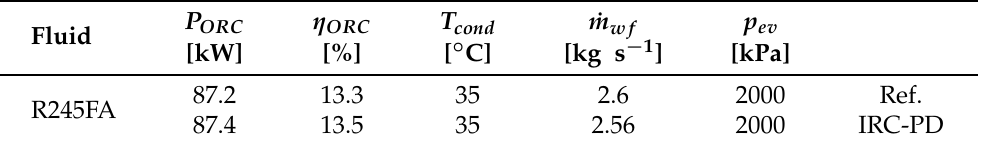
Table 4. Comparisons between the results obtained by the IRC-PD tool and the ones listed in ref. [60]. In the thermal loop flows the Dowtherm Q